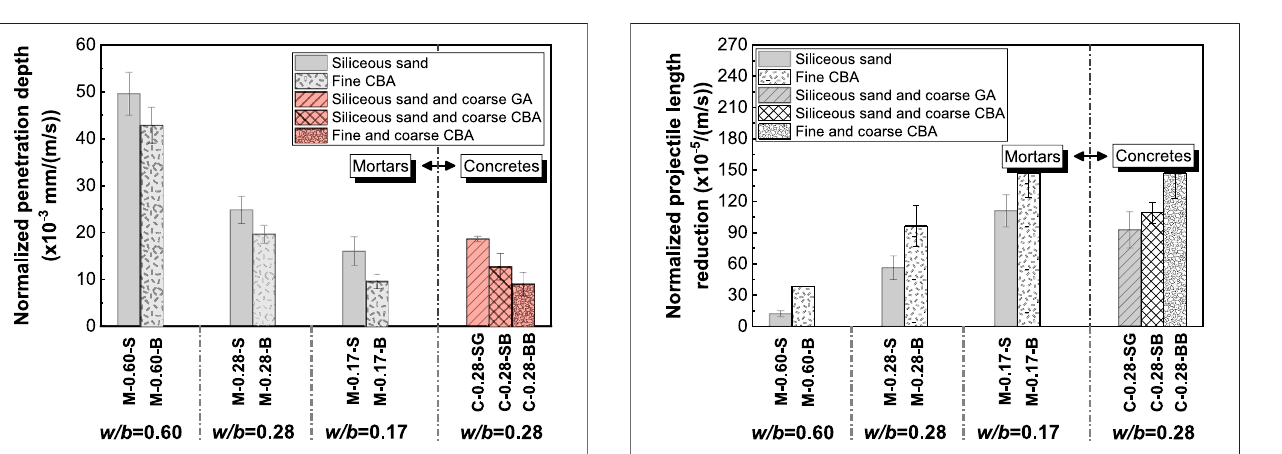
FIGURE 9 | Effect of CBA on the normalized length reduction of deformable copper projectile.